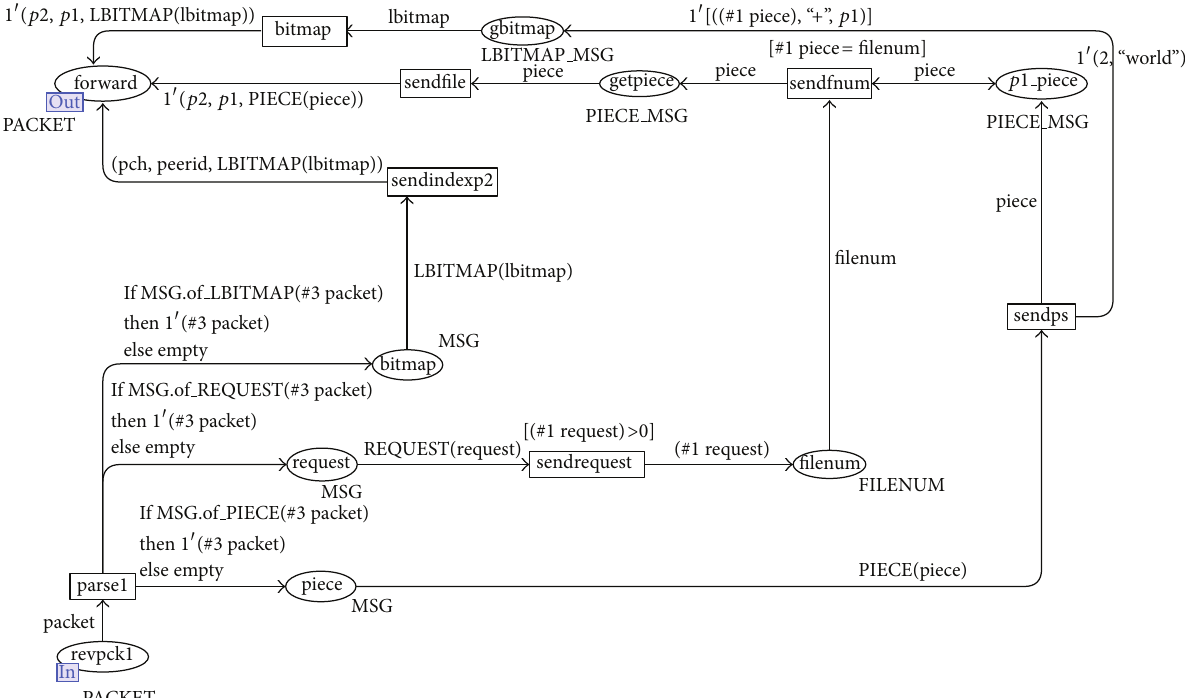
Figure 10: The receive page of a client in BT software system.